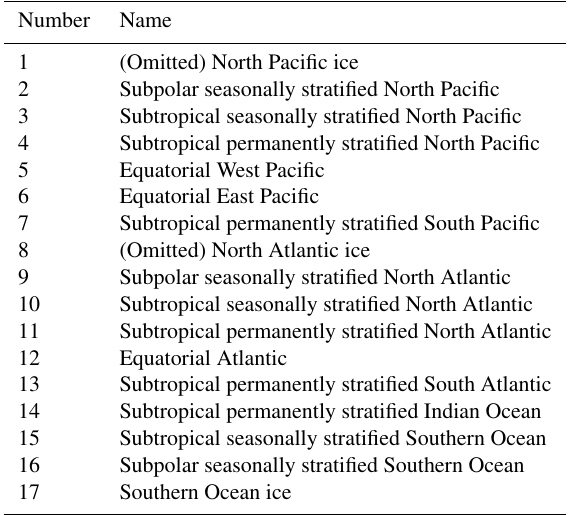
Table 2. Biomes from Fay and McKinley (2014) used for time se- ries comparison (Fig.